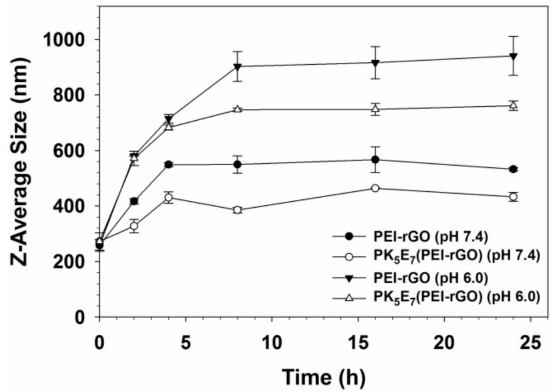
Figure 6. Z-average sizes of PEI-rGO and PK 5 E 7 (PEI-rGO) at pH 7.4 and pH 6.0 in serum condition (10% FBS). Data are shown as the mean ± S.D ( n =